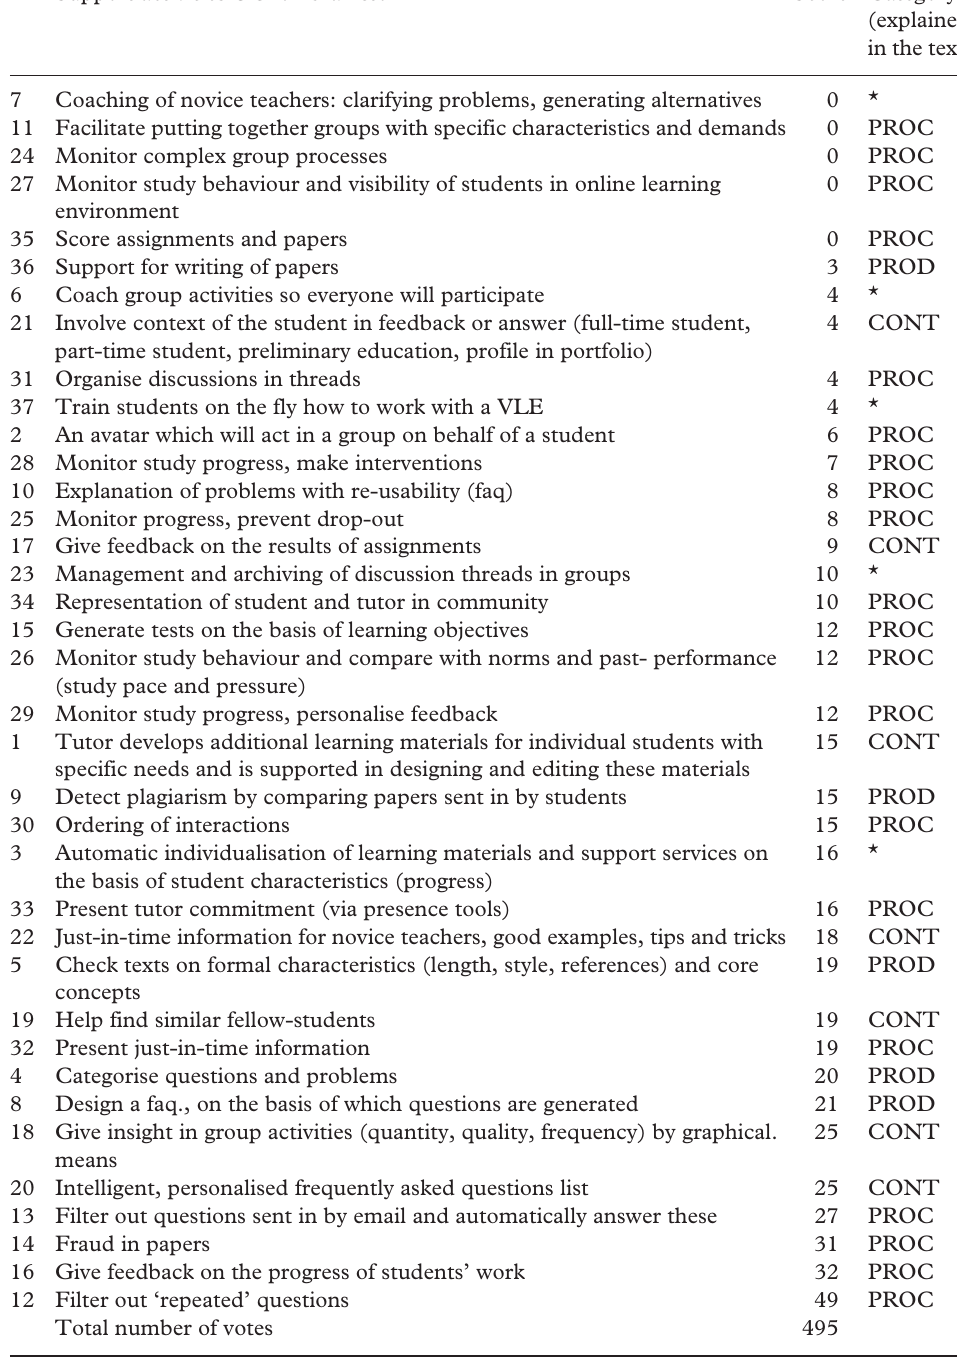
Table 1. Critical situations as identified by selected staff members of the OUNL ID Support activities OUNL